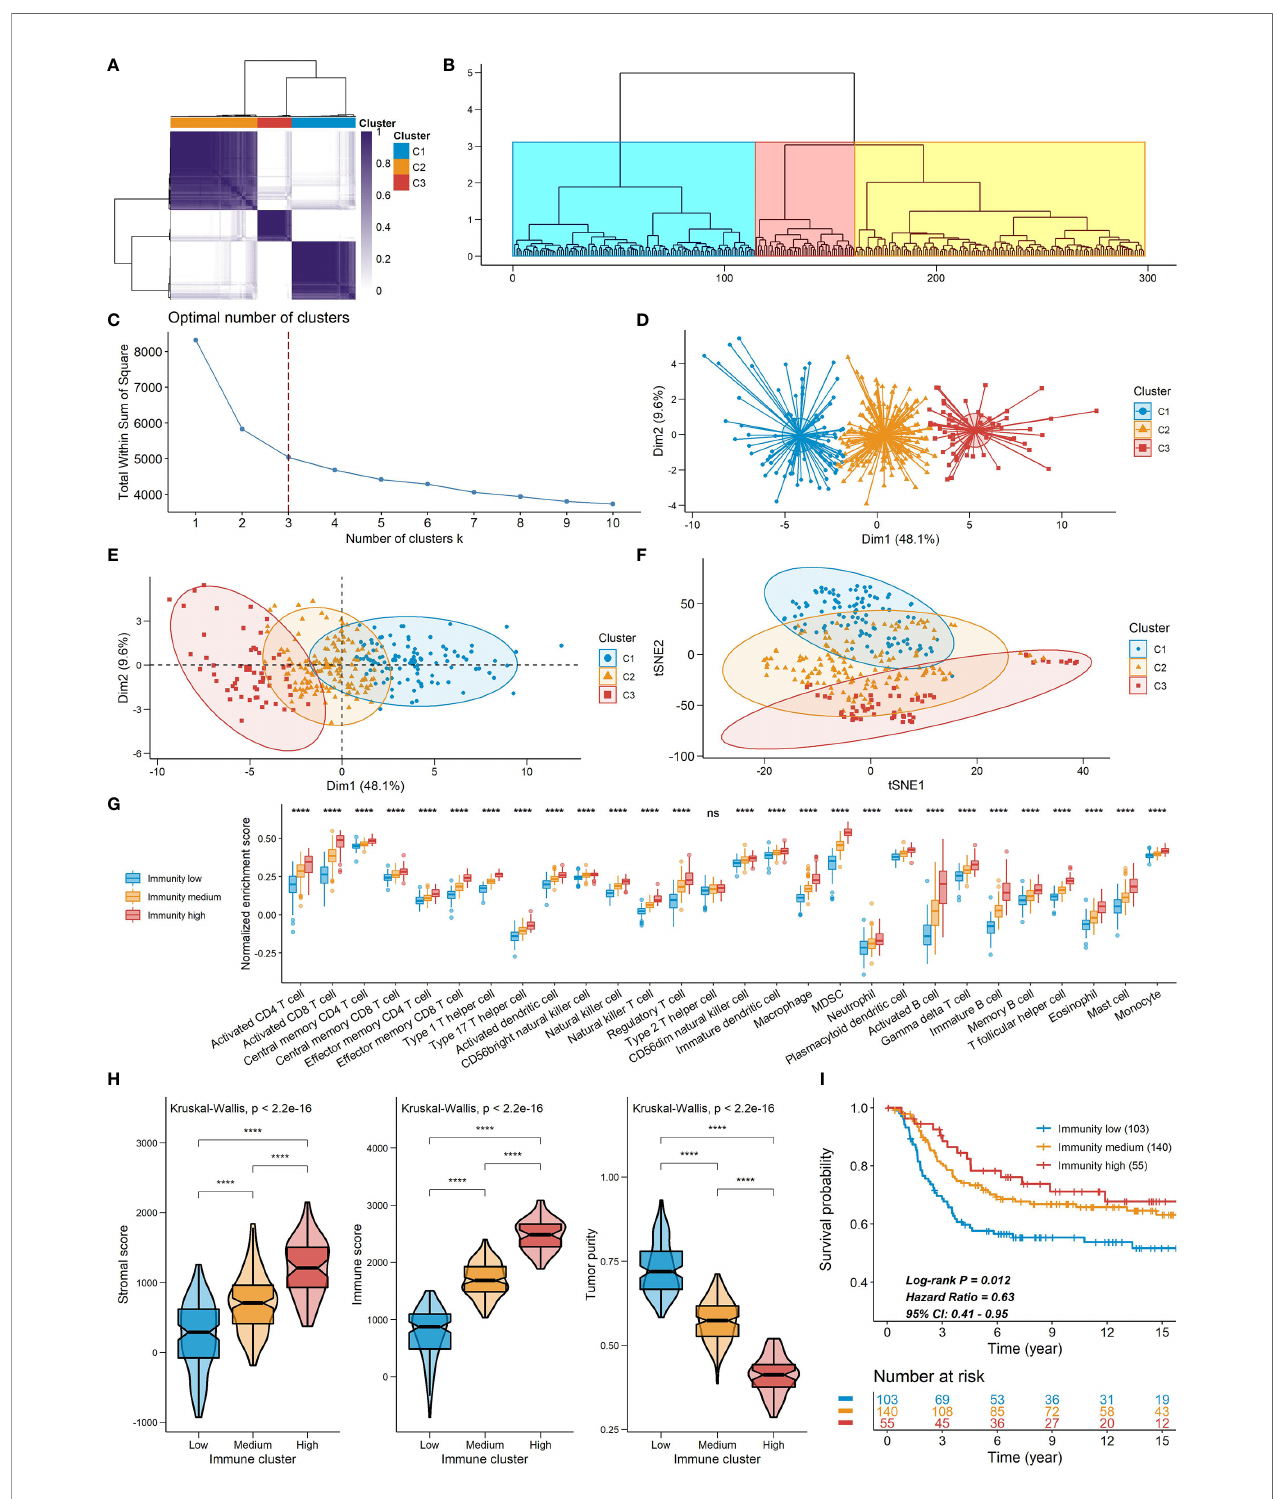
FIGURE 6 | Constructions of TME signatures in the METABRIC cohort. (A, B, D) Consensus clustering (A) , hierarchical clustering (B) and k-means clustering (D) of TNBC patients based on tumor-in fi ltrating immune cells to classify patients into three groups. (C) Screening for the optional number of clusters with k-means clustering. (E, F) PCA (E) and t-SNE (F) for dimensional reduction of TNBC patients based on tumor-in fi ltrating immune cells. The three clusters detected by the consensus clustering were shown. (G) The relative abundance of tumor-in fi ltrating immune cells in the three immune clusters. (H) A comparison of stromal score, immune score and tumor purity among the three clusters. (I) Kaplan-Meier curves of the three immune clusters. Plots were truncated at 15 years, but the analyses were conducted using all of the data **** P < 0.0001; ns, P > 0.05).